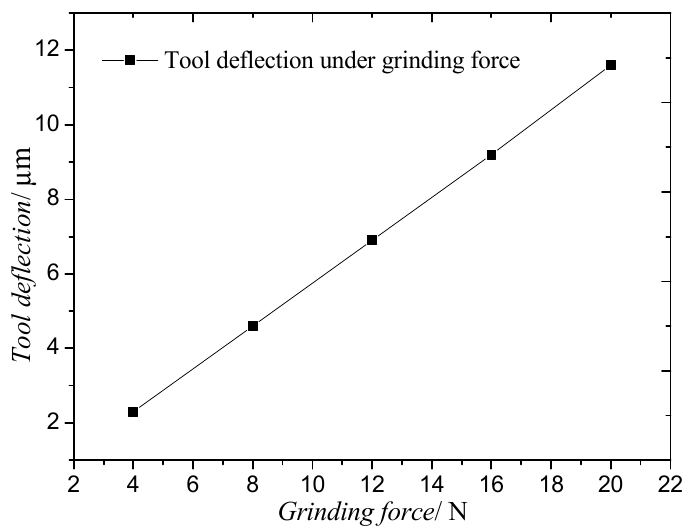
Figure 5. Tool deflection under grinding force.